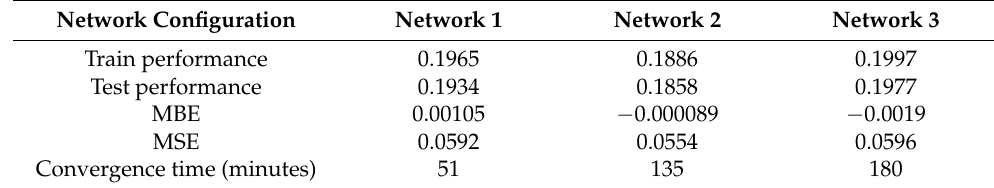
Table 16. Unified electric power production and consumption prediction results.